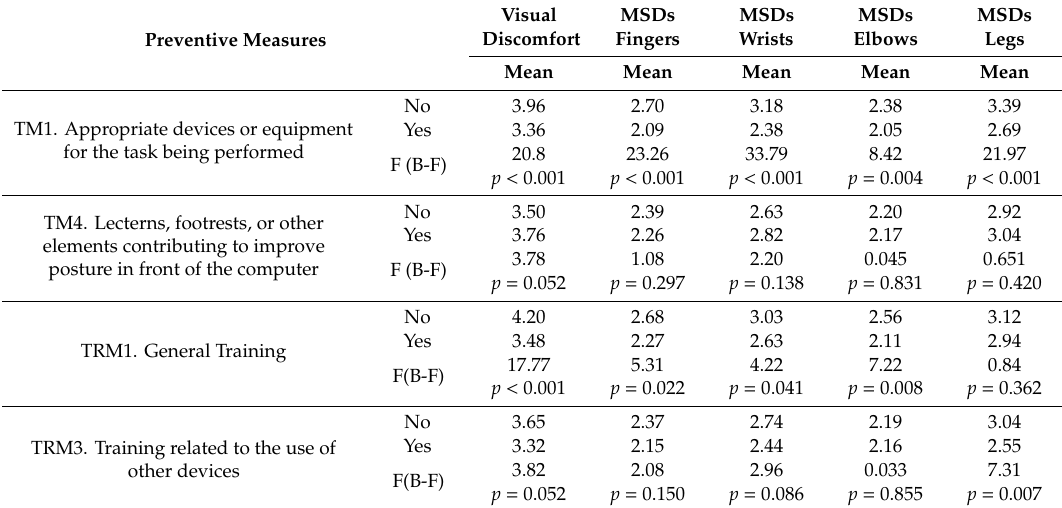
Table 8. Relations between preventive measures. Visual discomfort. And musculoskeletal disorders (2).